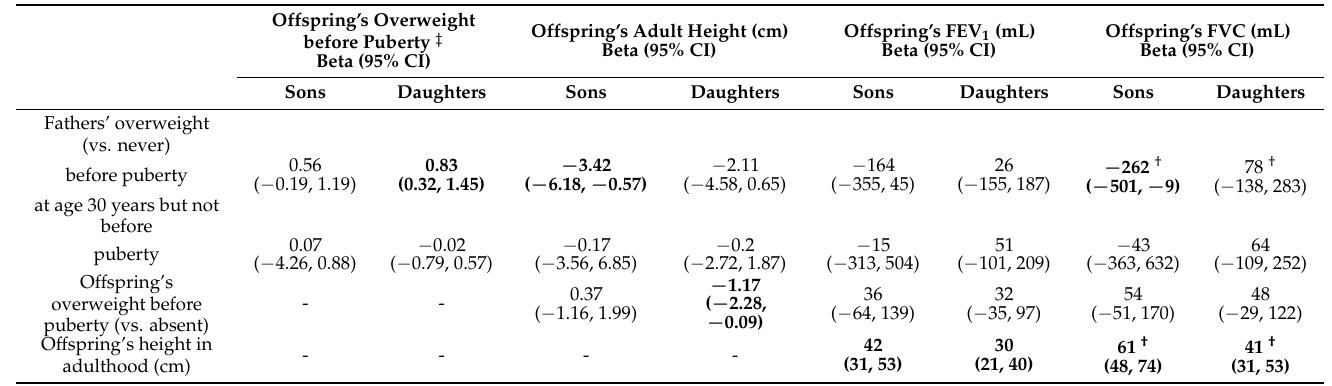
Table 2. Natural direct effects * on offspring’s pre-bronchodilator FEV 1 and FVC (model 1) within the paternal